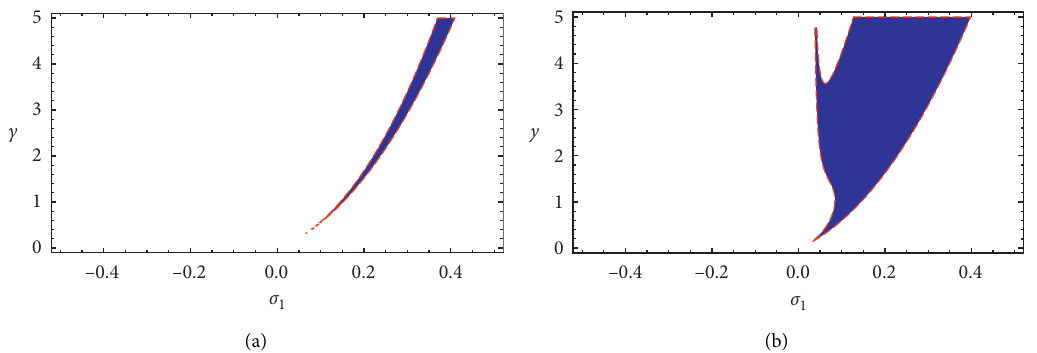
Figure 8: The system solution behavior in c − σ system with τ � τ